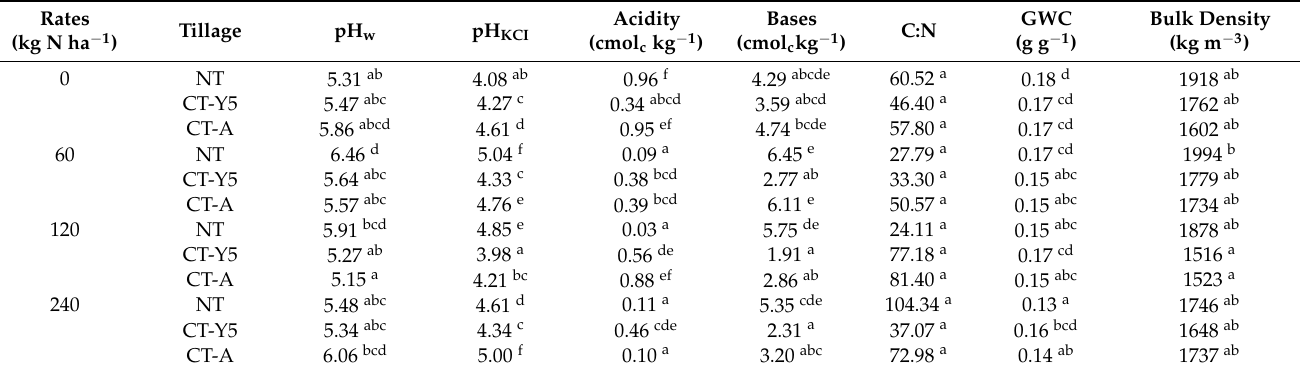
Table 3. Soil characteristics under different tillage systems and N fertilizer application rates at 20–30 cm